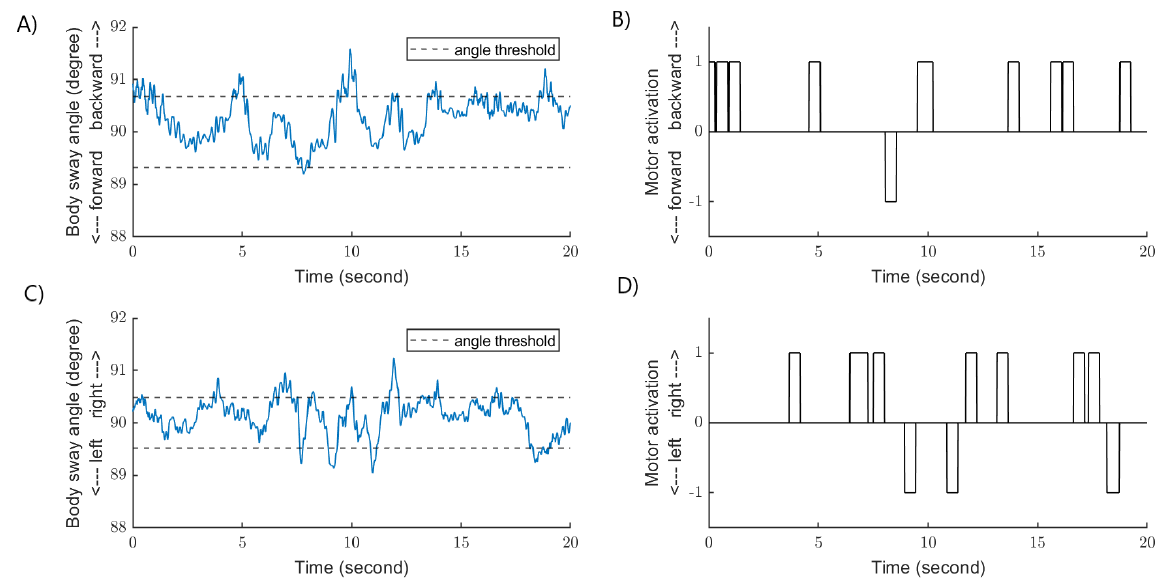
Figure 3. Examples of real-time body sway angle (blue lines, panel ( A , C )) and the thresholds (black dashed lines) for a representative participant. Panel ( A , B )) shows body sway along the AP axis and corresponding activation (1) and deactivation (0) of the vibration motors. Panel ( C , D )) shows body sway along the ML axis and corresponding activation (1) and deactivation (0) of the vibration mo- tors. The vibration motors were activated in the direction of body sway when the body sway angle was larger than the participant-specific threshold. Vibrotactile stimulation lasted for a minimum of 0.5